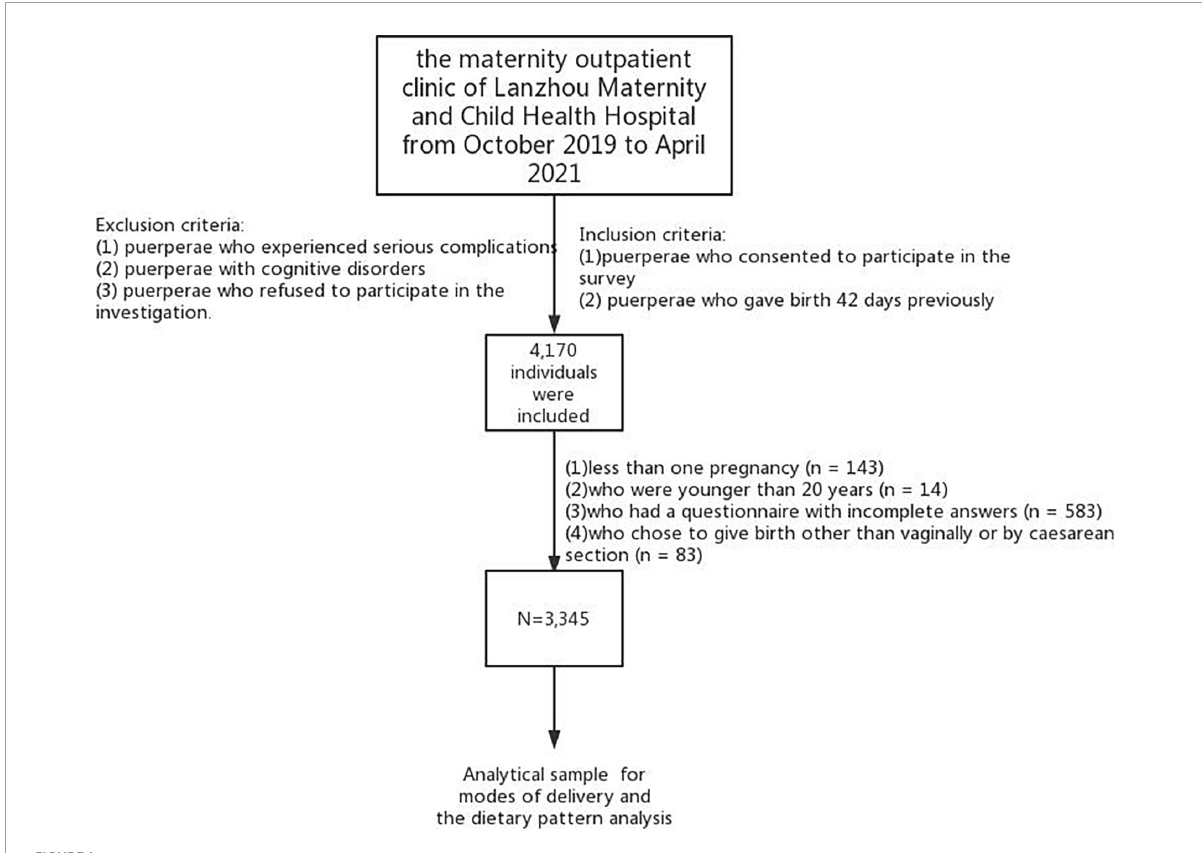
FIGURE1 Participant flow